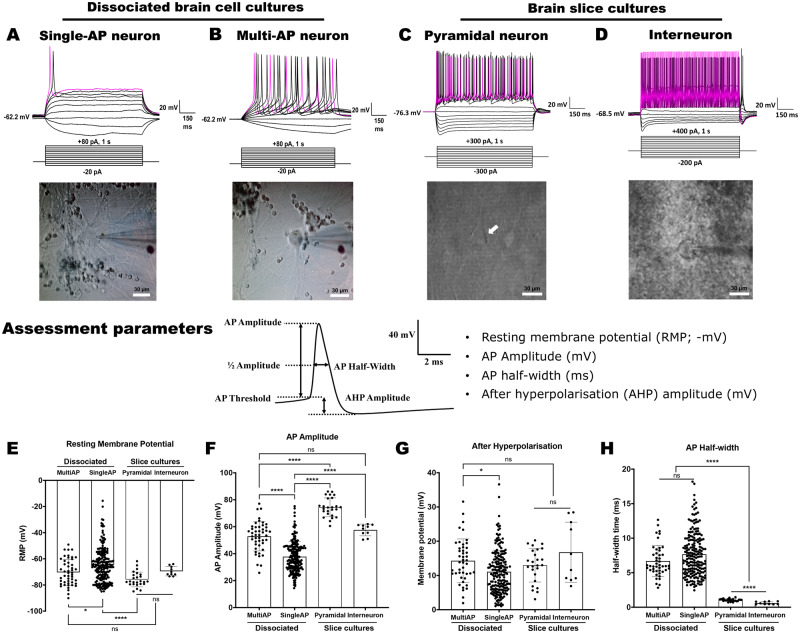

A comparison of the electrophysiological properties of dissociated primary human neurons with human brain slice cultures. (A–D) Representative whole-cell patch-clamp recordings and differential interference contrast images of a single- (A; DIV 31) and a repetitive-AP-firing (B; 23 DIV) dissociated neuron, and a pyramidal (C) and an interneuron (D) from slice cultures under current clamp in response to 1-s current steps. The white arrow in the differential interference contrast image of C indicates the layer 2/3 pyramidal neuron that was patch-clamp recorded. Scale: 30 µm. (E–H) The recorded neurons were categorized by AP-firing patterns and assessed for RMP (E), AP-amplitude (F), AHP amplitude (G) and AP half-width (H), as shown in the ‘Assessment parameters’ illustration. The dissociated neurons that elicited repetitive multi-firing APs and those that only elicited single-AP were compared to pyramidal-like and interneuron-like neurons recorded from cortical slice cultures. For data with equal variance, a one-way ANOVA analysis with Tukey’s multiple comparison test was employed, and where variance was different, logarithmically transformed data were analysed using a general linear mixed model. ns = P > 0.05, *P < 0.05 and ****P < 0.0001